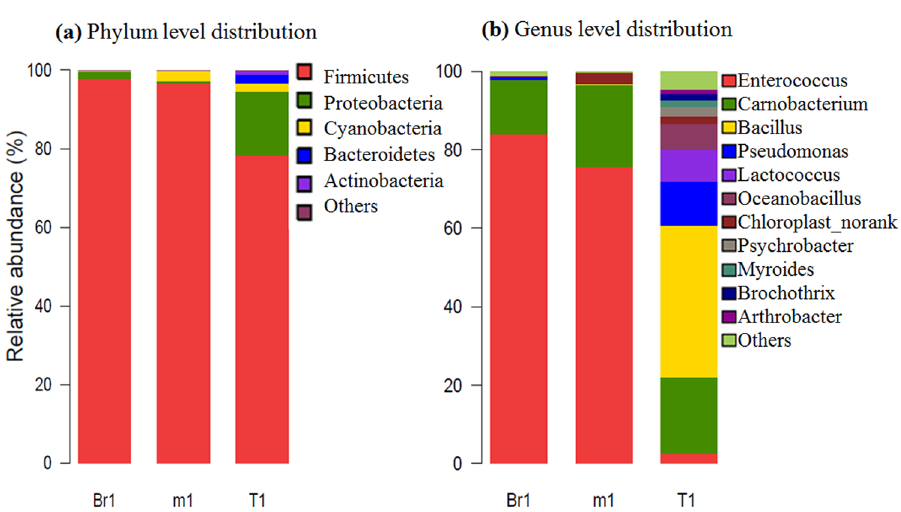
Figure 2. Taxonomic distribution of larval midgut samples. ( a ) Phylum distribution for all samples; ( b ) genus distribution of all